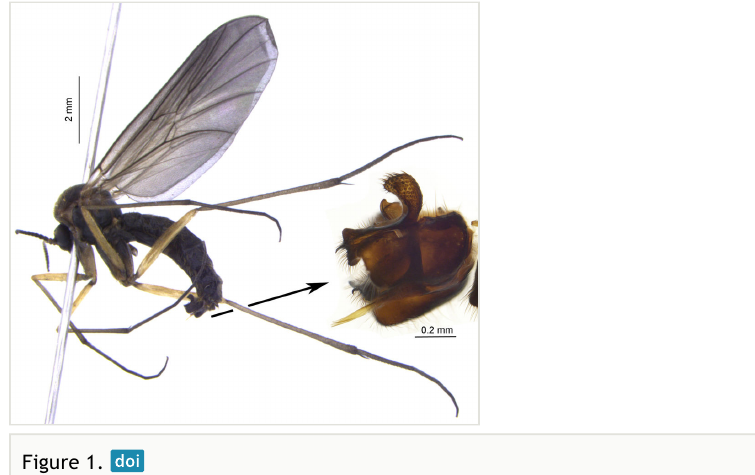
Figure 1. Ditomyia macroptera Winnertz, male specimen from Bulgaria: general habitus in lateral view (left) and close lateral view of terminalia